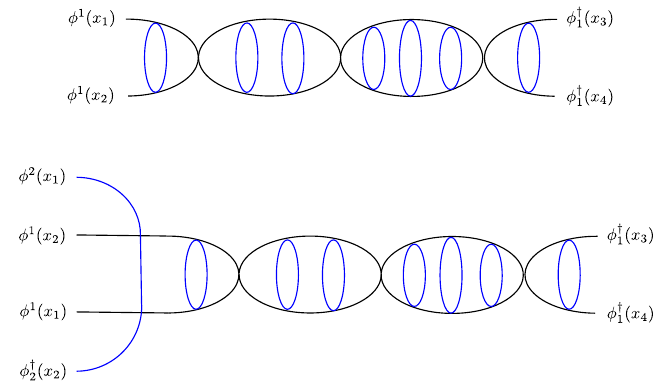
Figure 4 . Typical Feynman diagrams contributing to the perturbative expansions of (B.6) (top) and (B.7) (bottom). The top diagram [31, 32] is a linear chain of scalar loops, built using a pair of ξ 2 -vertices and interspersed with α 2 -vertices. The propagators are curved to hint at their cylindrical 1 topology. The bottom diagram ends with two ξ 2 -vertices. The colours represent the “flavours” of the scalars: black for φ 1 and blue for φ 2 . The topologies are related to those in figure 1 of